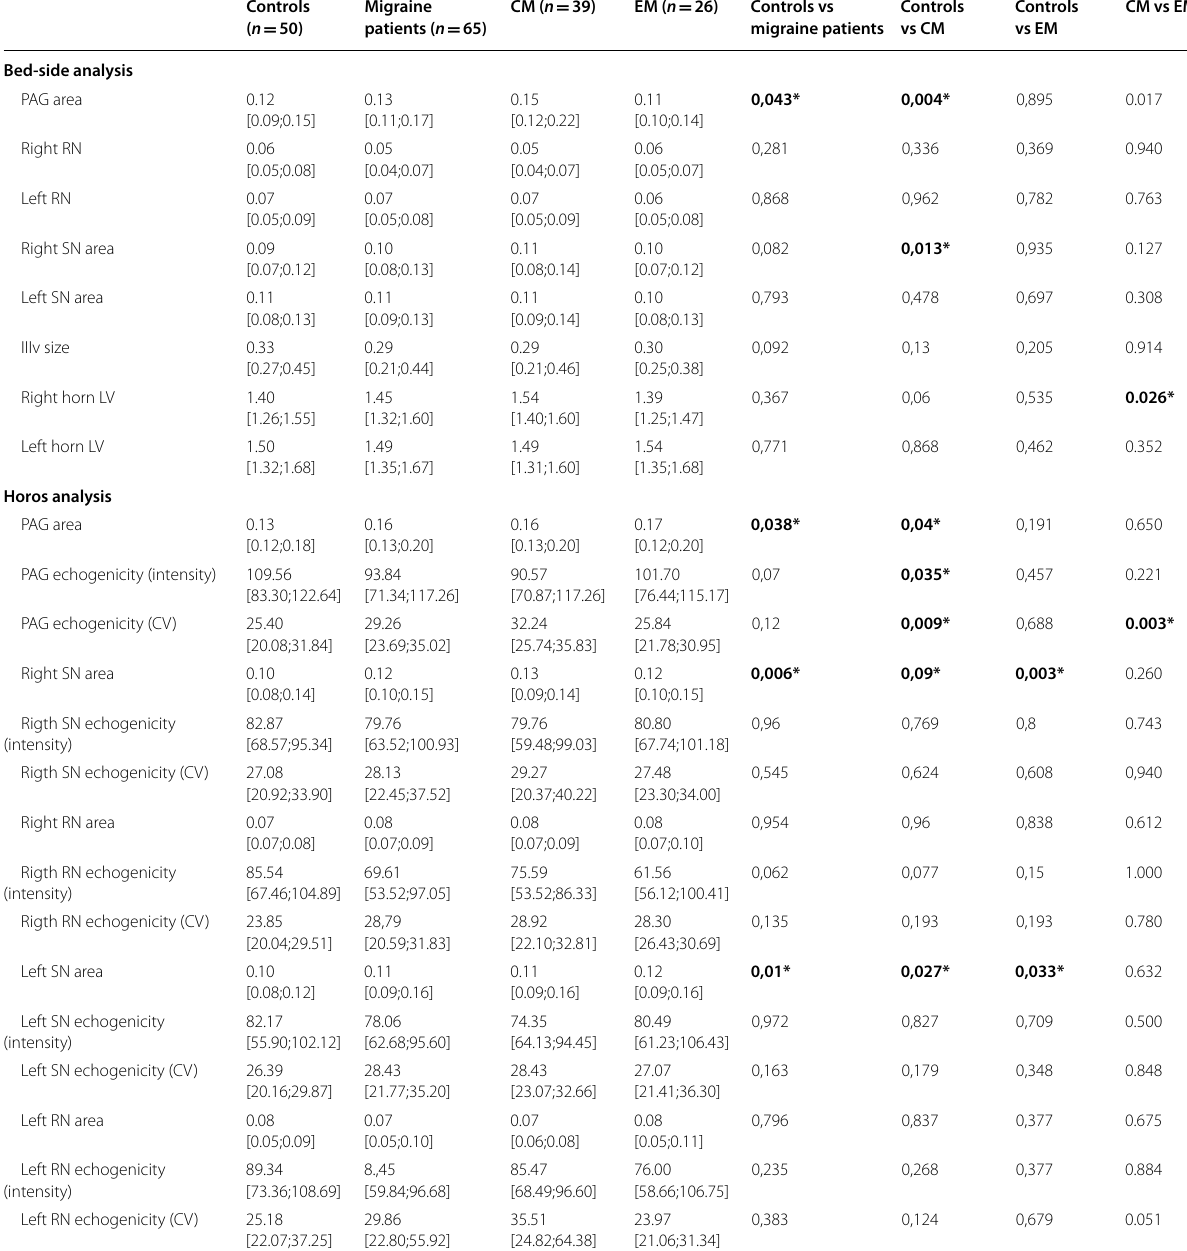
Table 2 Sonographic variables of patients with migraine and controls